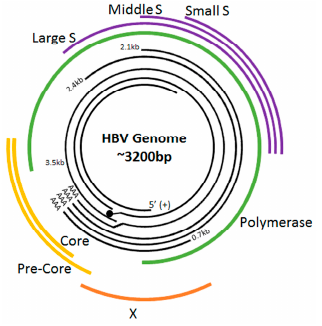
Figure 1. Hepatitis B Virus (HBV) Genome Organization. The innermost two black lines represent the full-length minus (–) strand (with the terminal protein attached to its 5 ′ end) and the incomplete plus (+) strand. The outer black lines represent the 3.5, 2.4, 2.1 and 0.7 kb mRNA transcripts. The outermost lines indicate the translated HBV proteins.